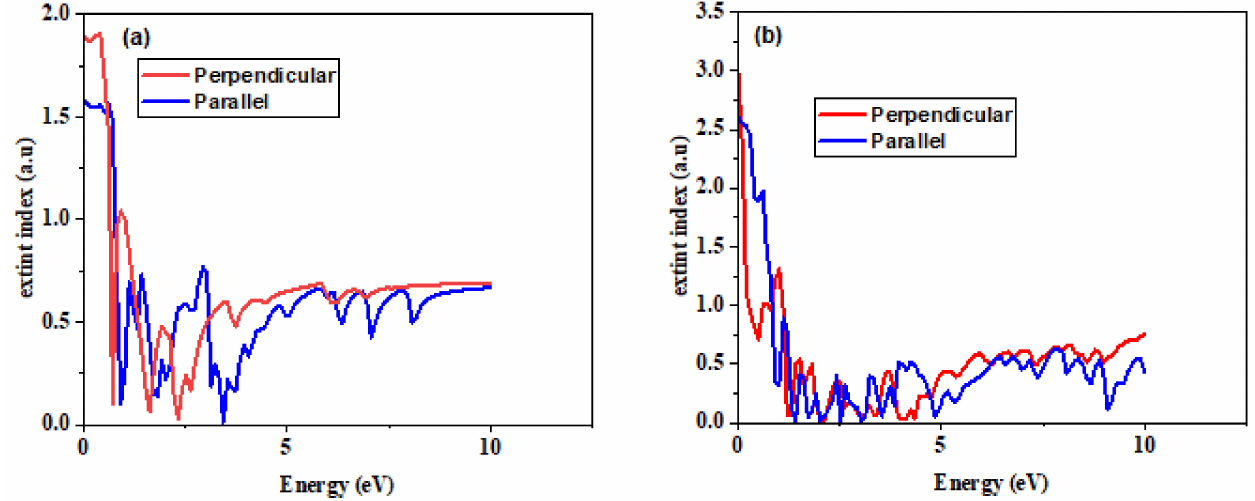
Figure 9. Optical extinction of ( a ) armchair (5, 5) SWBNNT and ( b ) armchair (5, 5) SWCNT